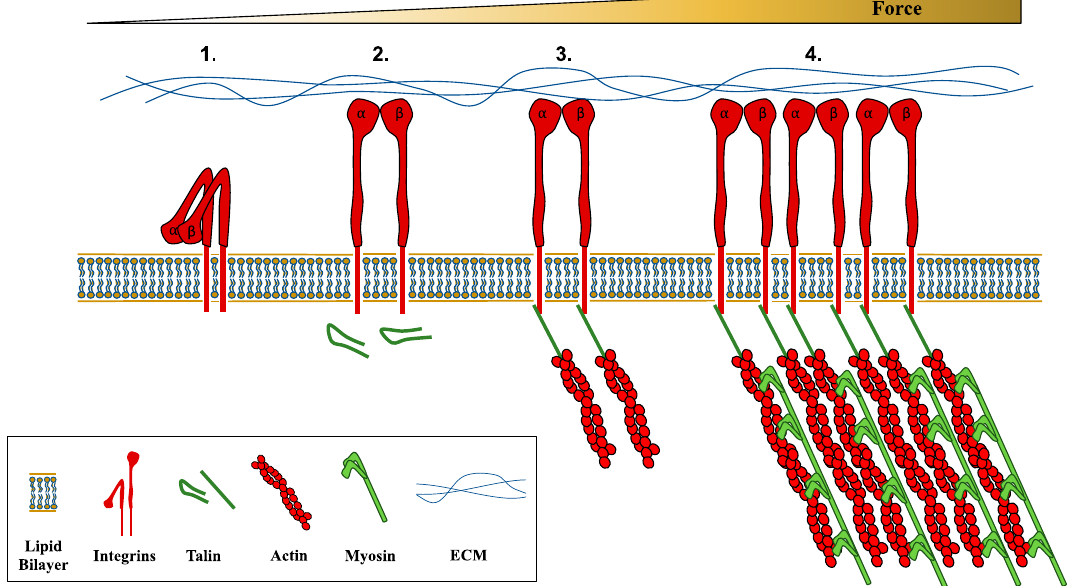
Figure 2. Integrins as force-dependent mechanosensors. Left to right with increasing force: 1 . Tensile forces can extend α / β integrins from a downward-bent fashion to a thermodynamically unfavorable extended-open confirmation. 2 . Force-induced catch-bond formation with ECM prolongs bond lifetime. 3 . Force-induced conformational changes to the intracellular adaptor protein talin, lock talin in an unfolded state and increases adhesion growth. 4 . Finally, force can increase integrin clustering, leading to mature integrin adhesions.